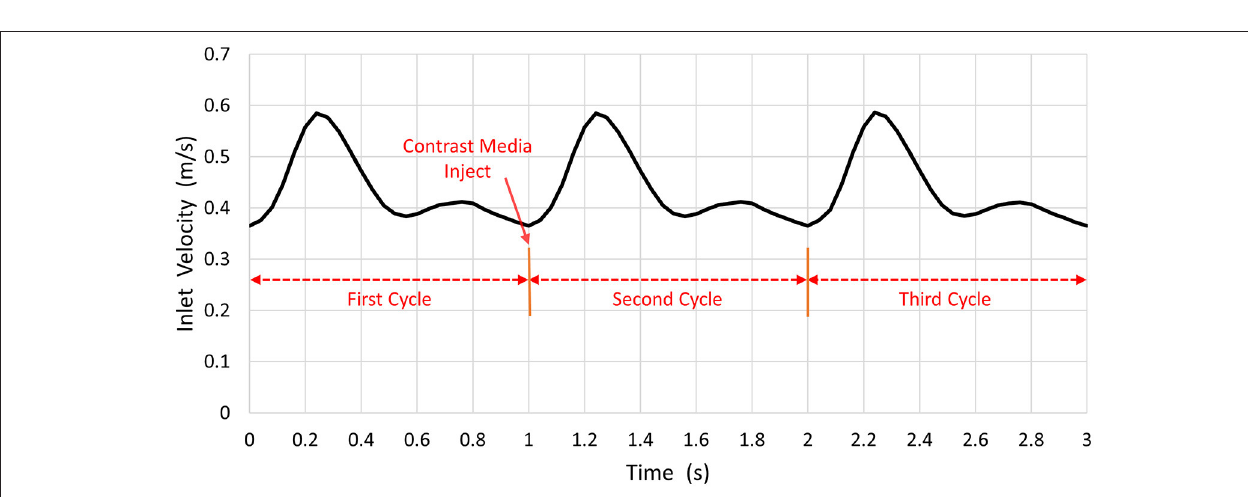
FIGURE 3 | The blood inlet